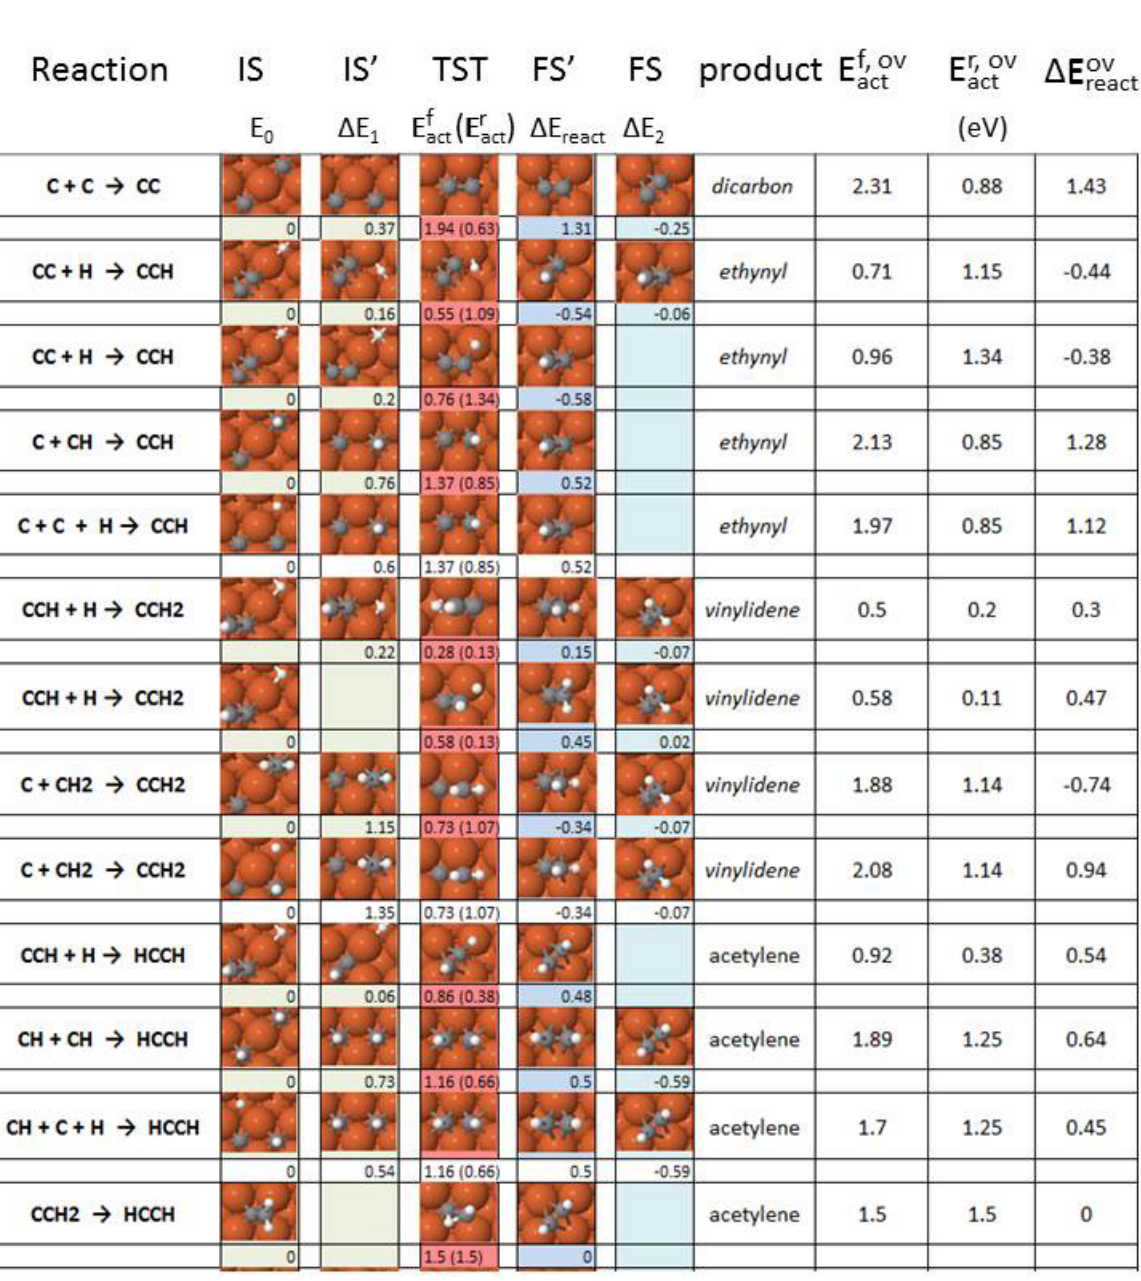
H (x = 0–6) formation, including ( a ) acetylene formation 2 x